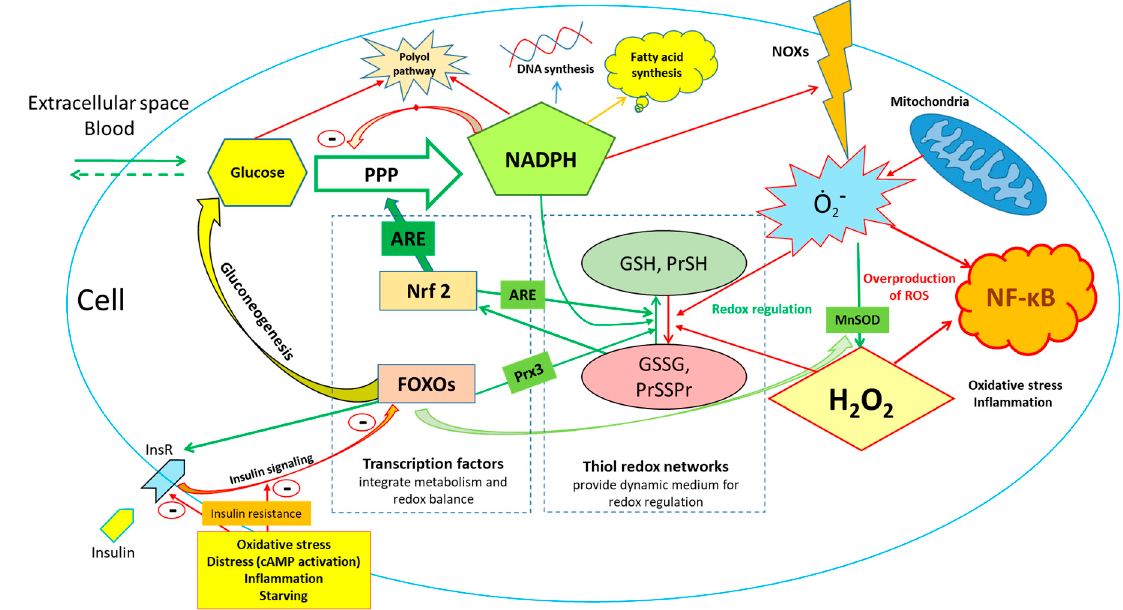
Figure 2. Glucose availability is a major factor in the maintenance of redox homeostasis through the reduction in oxidized NADP + , which is used for the subsequent reduction in oxidized glutathione and thiols. At the same time NADPH is used for synthesis of DNA and fatty acid synthesis and is needed for activities of NADPH oxidases, NO-synthase and other processes. The scheme is simplified and regulatory networks functioning in living systems are much more complex and include other mechanisms and feedback loops. For example, it was recently shown that the deletion of Nrf2 in mice can be—to a large extent—compensated by other adaptive mechanisms in conditions of caloric restriction [23]. This suggests that robust regulatory network beyond Nrf2 and FOXO transcription factors exists in order to maintain redox balance. Abbreviations: PPP—pentose phosphate pathway,